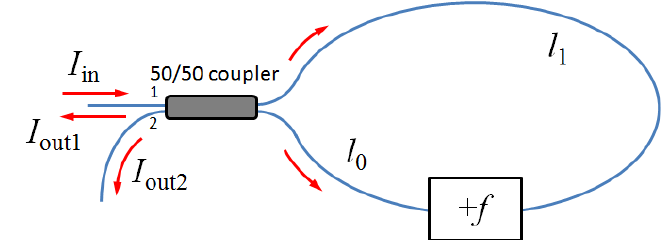
Figure 1. A frequency-shifted Sagnac interferometer formed by connecting the output of a 50/50 fiber directional coupler with an optical frequency shifter